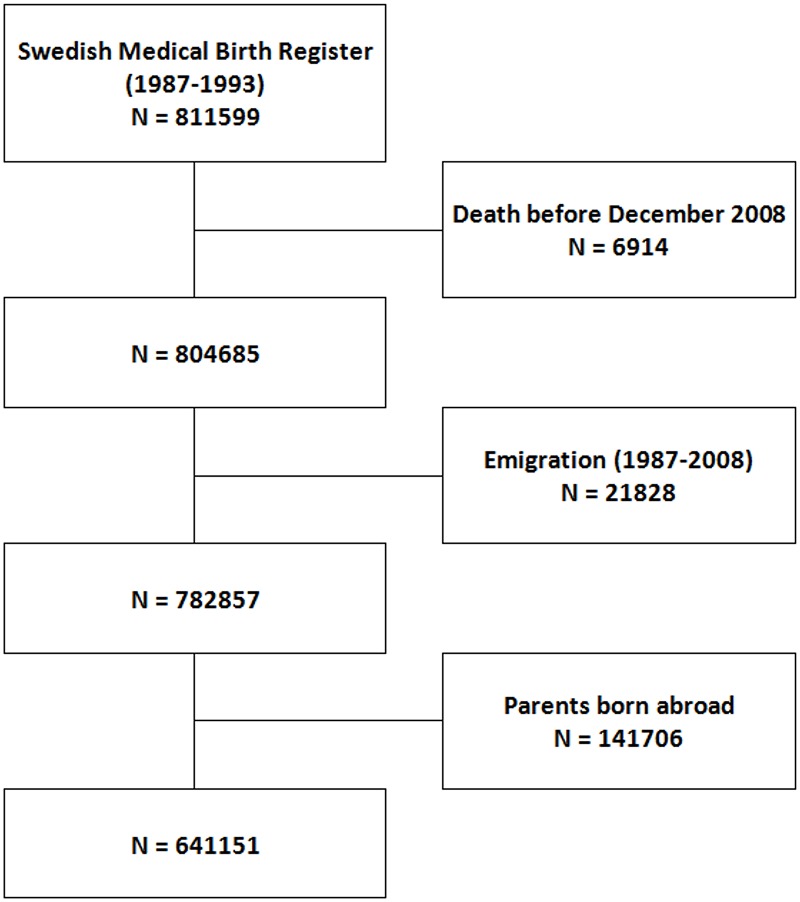
Study population.